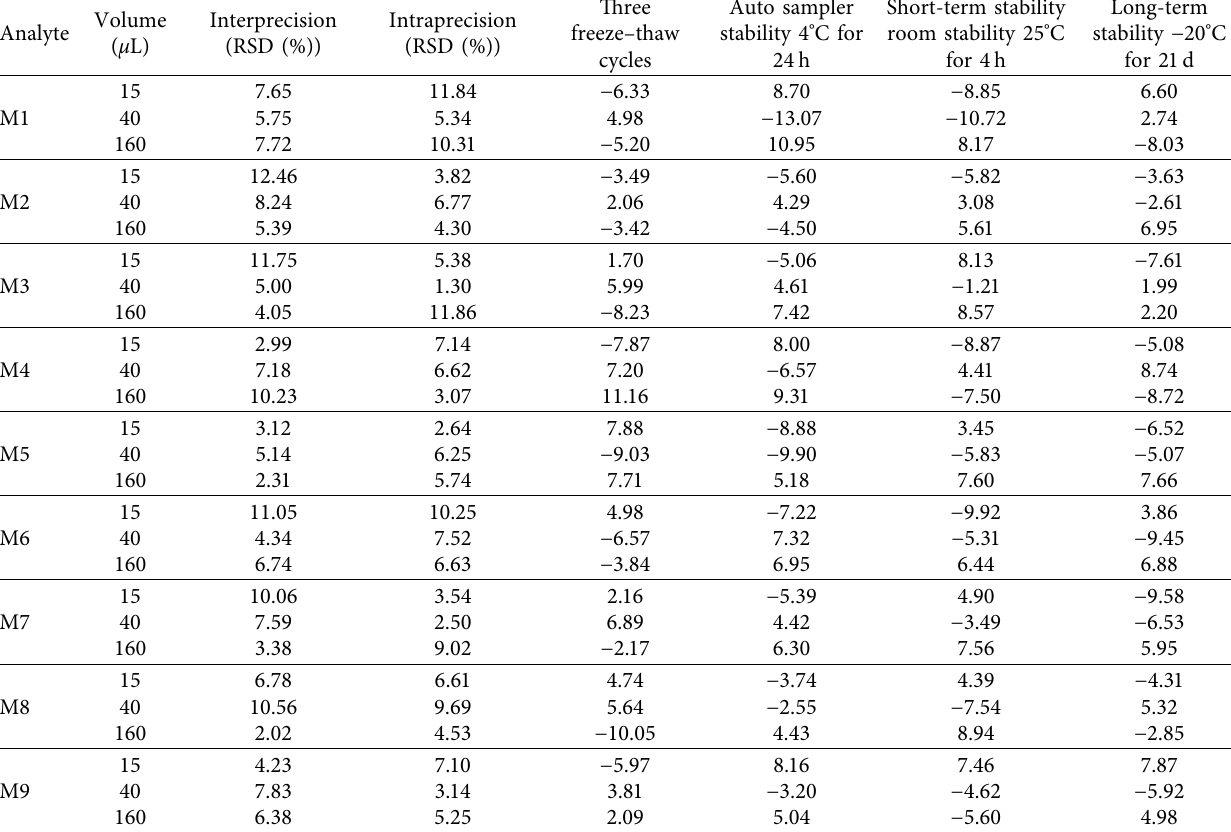
Table 9: The precision and stability of the